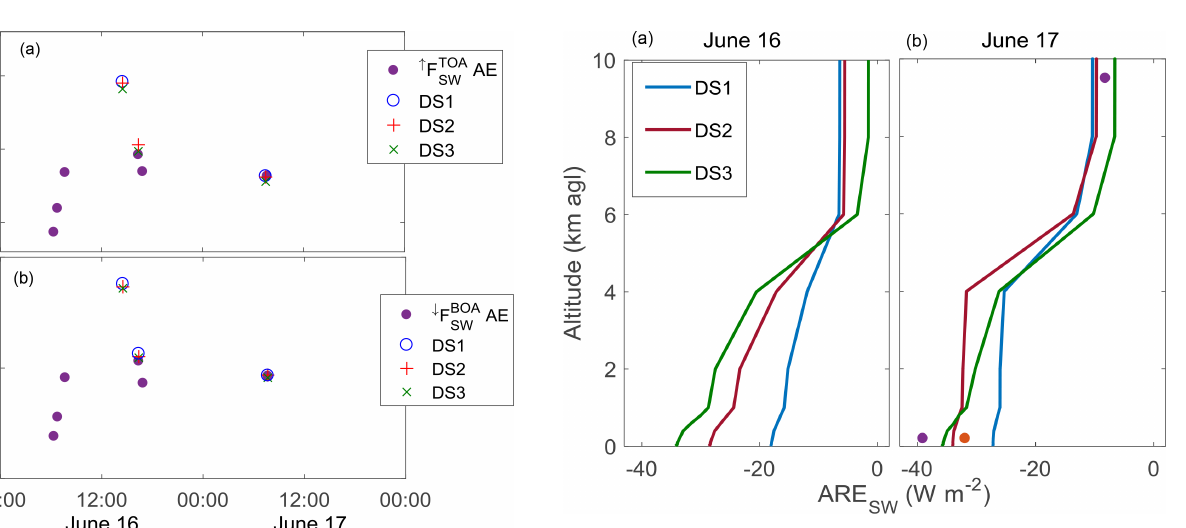
Figure 7. Time series of the ↑ F SW at the TOA (a) and ↓ F SW at the BOA (b) for the period 16–17 June. The purple dots are AERONET fluxes, and GAME output data for different inputs are represented by the blue circles (DS1), red crosses (DS2), and green crosses (DS3).